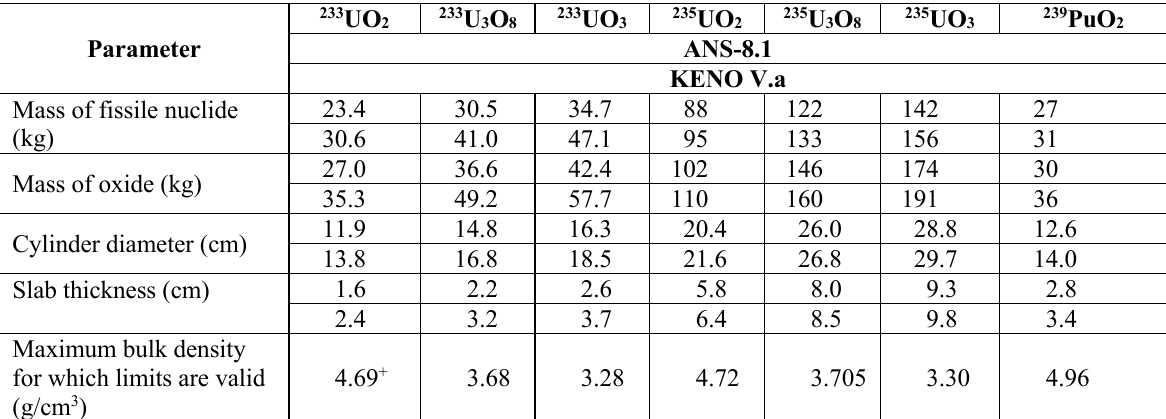
Table V. Single-parameter SCLs for oxides containing no more than 1.5% water by weight at half